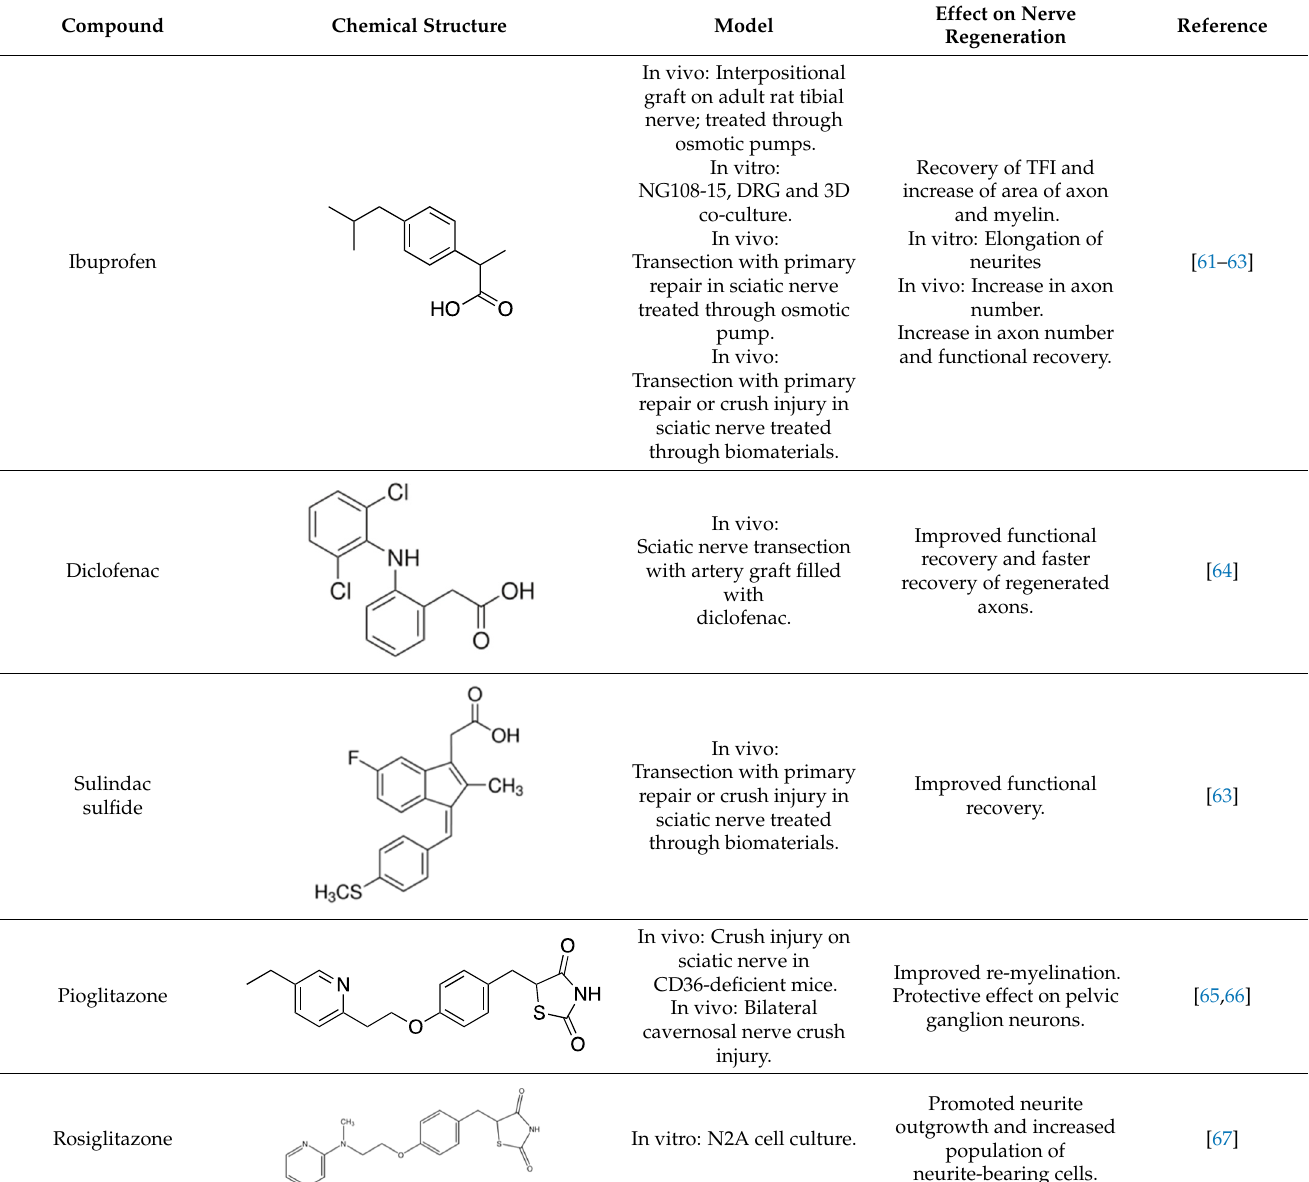
Table 1. Peripheral nerve studies that have explored the regenerative or functional recovery effects of drugs and small molecules that target PPAR- γ .